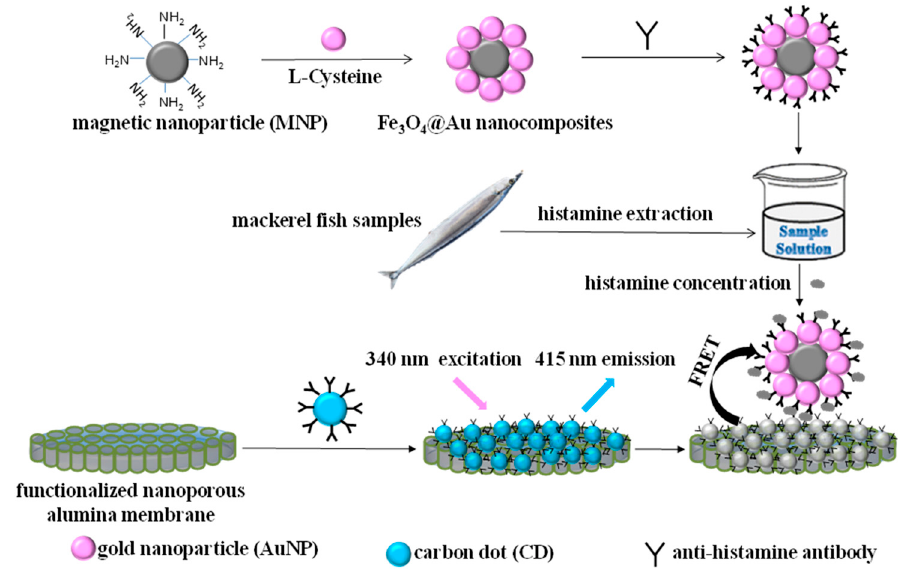
Figure 1. Schematic diagram of histamine extraction and concentration using the CD-modified nanoporous alumina membrane and Fe 3 O 4 @Au magnet nanocomposite-based FRET system for histamine determination.